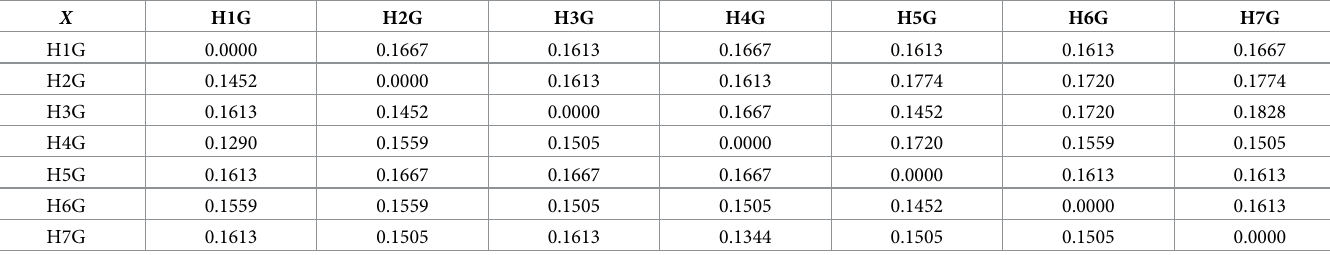
Table 3. The normalized direct-matrix